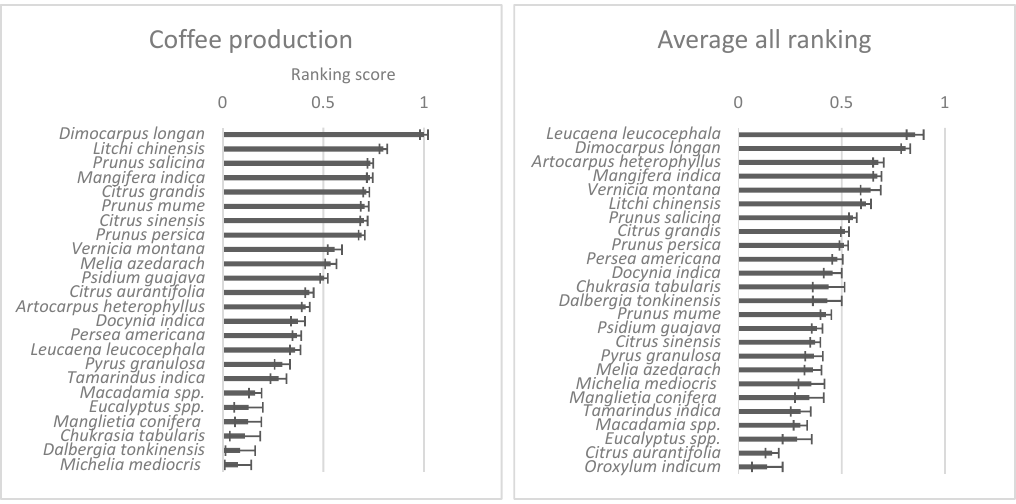
Figure A2. Pairwise ranking of tree species contributing to various tree services in coffee agroforestry systems with all groups combined.